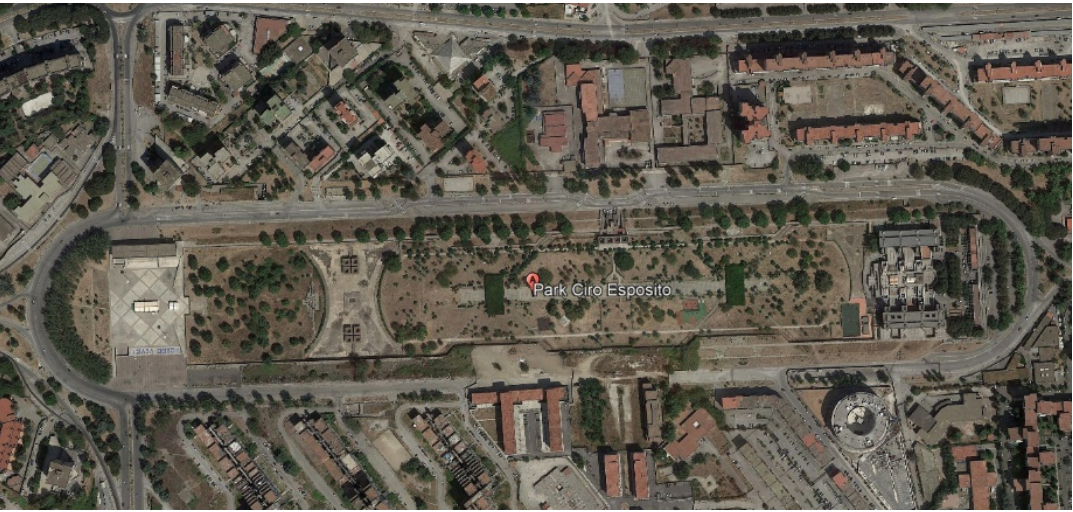
Figure 5. Aerial view of Ciro Esposito park, Scampia, Naples. Source: Google Earth.